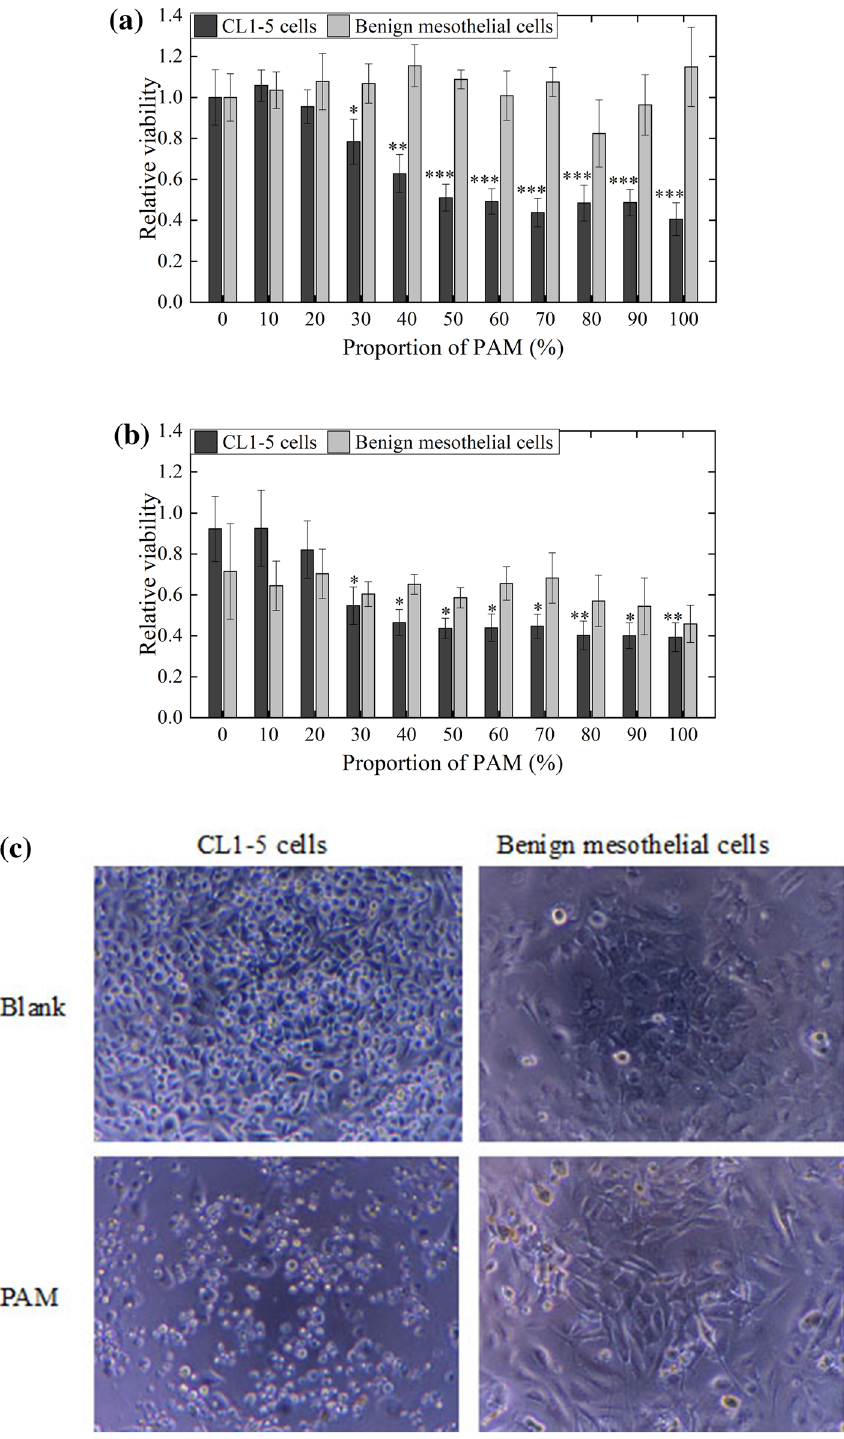
Figure 6. CL1–5 cells and primary cultured benign mesothelial cells were treated with PAM at 37 °C ( a ) or 43 °C ( b ) for 2 h. The relative viability is shown comparing to the treatment of 0% PAM (RPMI without plasma treatment) at 37 °C. The MTT assay was performed after further culturing for 1 day. Data are mean and SD values (n ≥ 3). * P < 0.05; ** P < 0.01; *** P < 0.001 (Student’s t test). ( c ) Photographs of CL1–5 and benign mesothelial cells before and 1 day after receiving treatment with PAM for 2 h. ( d ) The attached and detached CL1–5 cells after PAM treatment were harvested separately. After the dual staining of Annexin V-Alexia 488 and PI, the apoptosis of CL1–5 cells with (attached cells and detached cells) and without (blank) PAM treatments was analyzed by flow